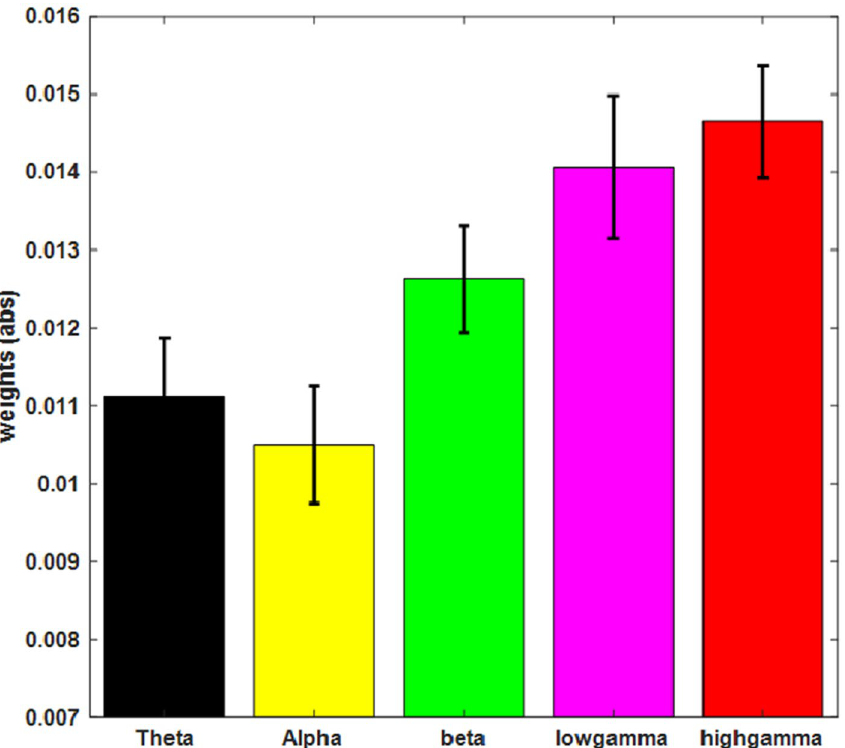
Figure 1. Distribution of maximal weights (abs) in the different frequency bands across the group of participants that could be reliably classified (n = 25). Nominal maximal weights were observed in the gamma band (low gamma: 30:59 Hz; high gamma: 60:120 Hz), but also theta- (4:7 Hz) and beta-band (13:24 Hz) contributed to the distributed prediction weights. Alpha (8:12) shows lower overall prediction